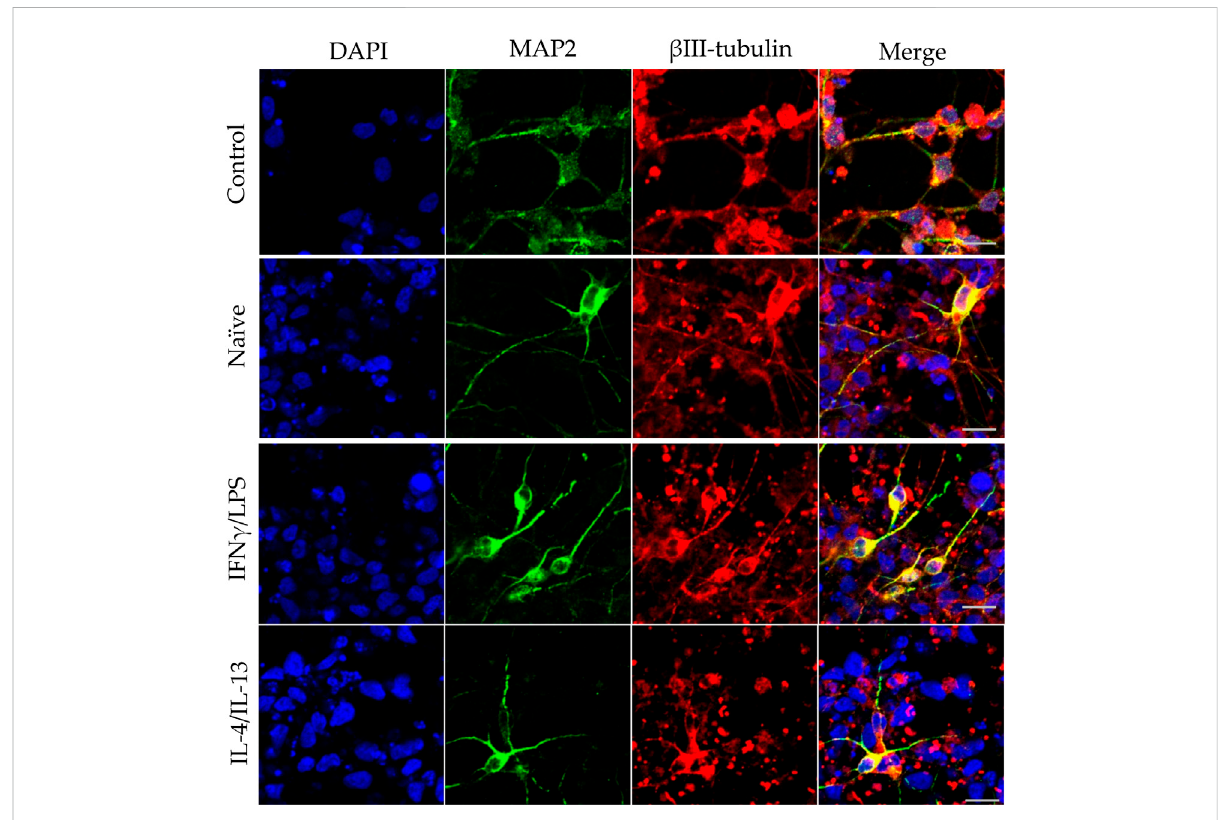
FIGURE 5 Effect of naïve and stimulated microglia on the dendrite development in differentiating neurons. NPCs were differentiated toward the hippocampal DG granule cells for 18 days. The differentiating neuronal cells were co-cultured with BV2 cells for 4 days (from day 14 to day 18). Microglial cells remained untreated (naïve) or were previously stimulated with an IFN γ /LPS or an IL-4/IL-13 cocktail as indicated. Confocal images depict day 18 neuronal cultures immunostained for the dendritic marker MAP2 (green) and the neuronal marker β III-tubulin (red). The samples were counterstained with DAPI (blue). Scale bars: 25